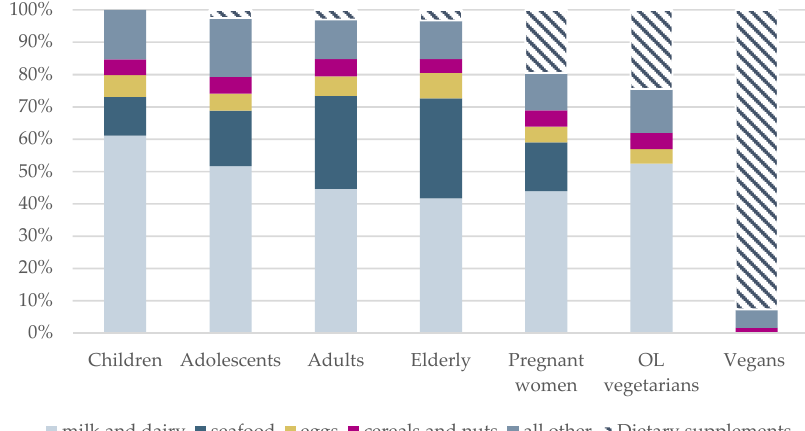
Figure 4. The contribution (%) to total iodine from food groups and dietary supplements in children, adolescents, adults, the elderly, pregnant women, ovo-lacto (OL) vegetarians and vegans.